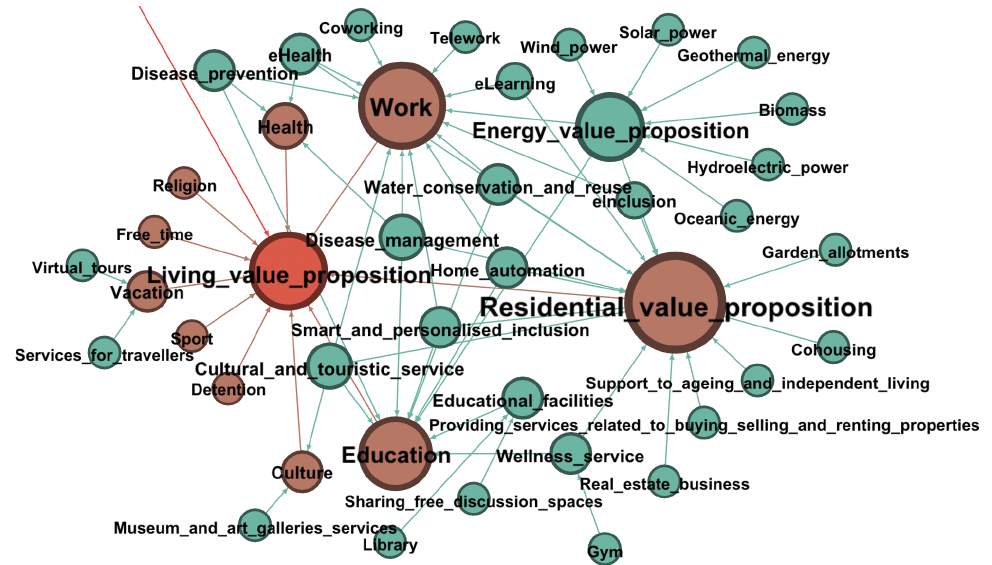
Figure 4. An excerpt from the business model ontology for smart cities representing the sub-hierarchy of the concept “Living value proposition”. This is depicted as a graph by using GEPHI. The red node represents the concept “Living value proposition”. Brown nodes represent the concepts at the first level of specialization, and green nodes represent the concepts at the other levels of